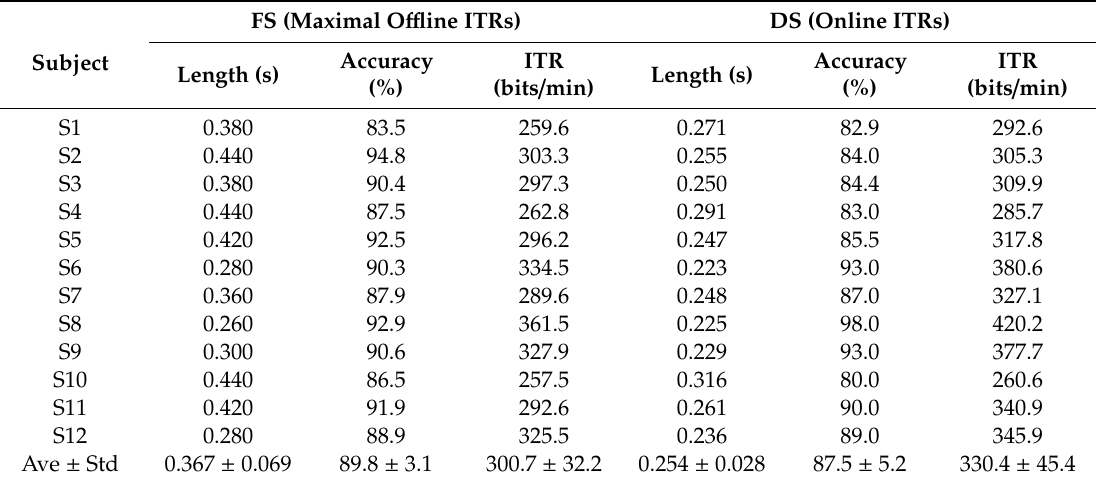
Table 1. Performance of cued-guided online experiments.